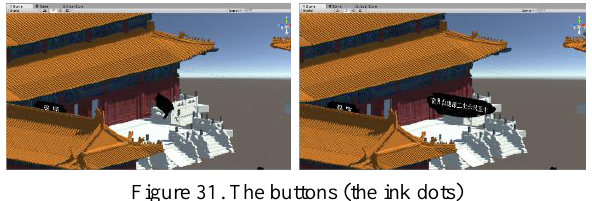
Figure 31. The buttons (the ink dots) Figure 32. The buttons triggered